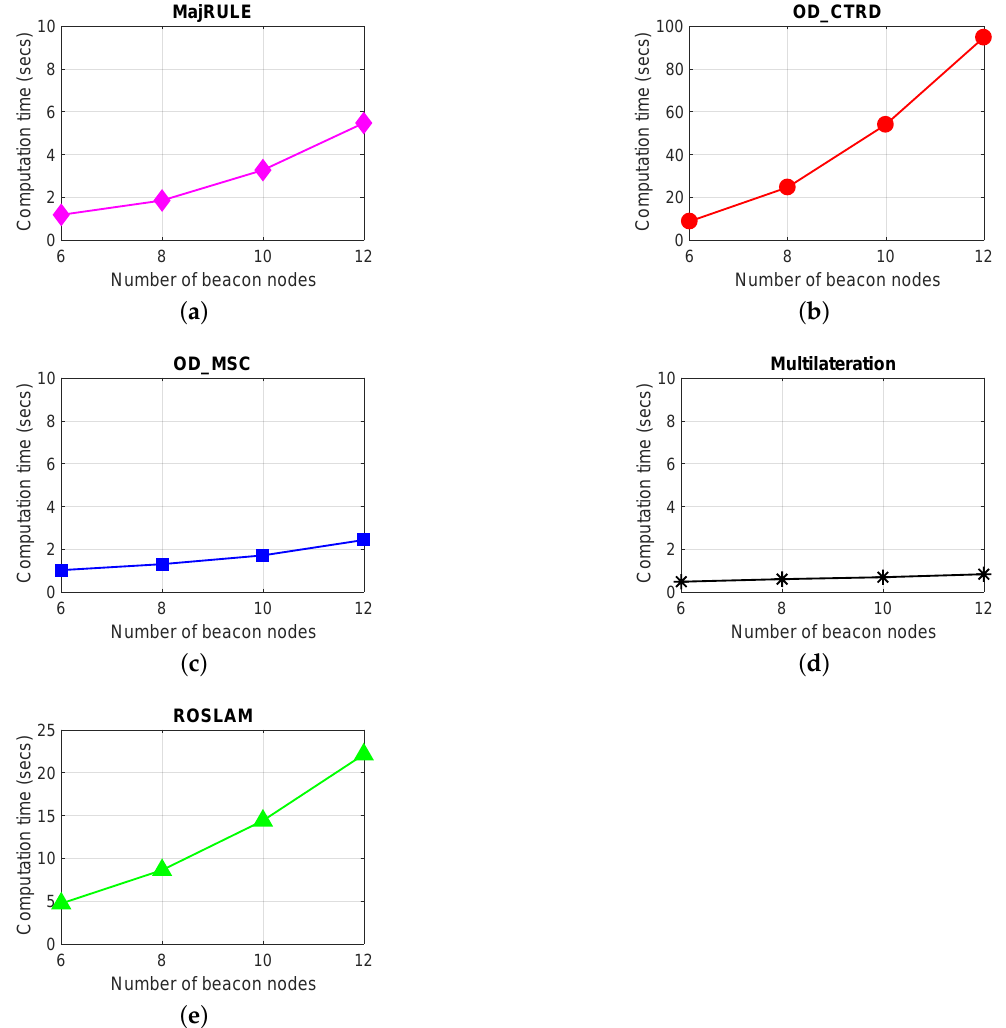
Figure 15. Shows the effect of the number of BNs on the computation time of the localization schemes: ( a ) MajRULE, ( b ) OD_CTRD, ( c ) OD_MSC, ( d ) Multilateration, and ( e ) ROSLAM. As explained in Section 4.1, the CR size is an important parameter for the proposed MajRULE localization scheme, since it affects the error performance as well as localization efficiency. To evaluate the effect of the CR size on these outcomes, we simulated the local- ization performance of 100 randomly distributed UNs in the network using the MajRULE scheme with different CR sizes. In Figure 16, we show the percentage of nodes localized and the corresponding average localization errors for different CR sizes used in the simula- tions experiment. The results indicate that using a very small CR size adversely affects the majority rule voting mechanism, as the individual pdfs will have minimal overlap and may not effectively localize the UN. Using a very large CR size, on the other hand, will increase the probability of the CRs overlapping, but increases the error margin for the candidate location estimates. Figure 16 also shows that CR size of 3 × 3 localizes the UN 80% of the time (as against 100% for 5 × 5 or larger CR sizes), however, 3 × 3 has the least localization error. So, we use 3 × 3 as the CR size for all our simulations and experimental